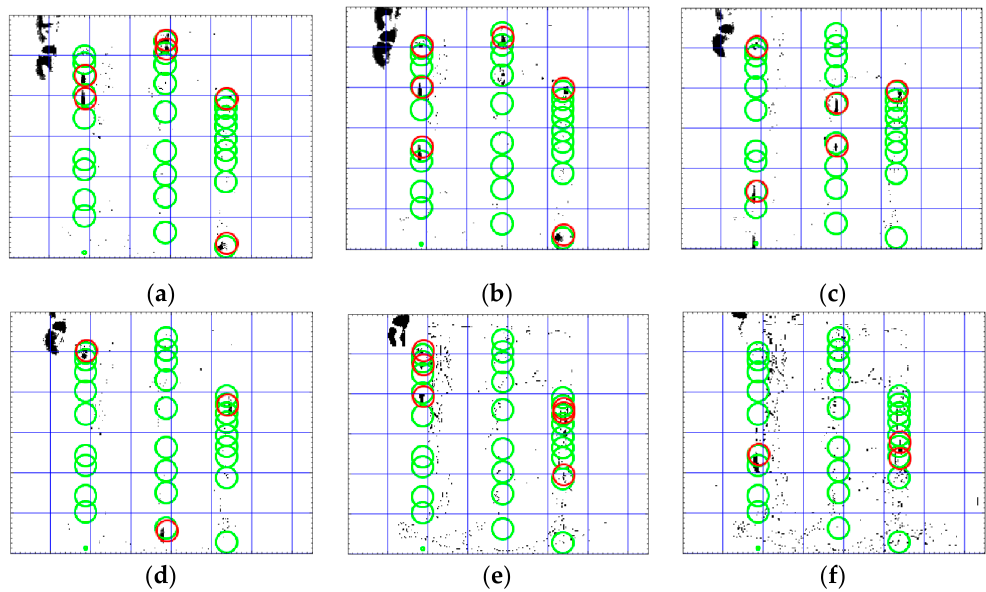
Figure 5. Detected leakage in test videos using the proposed multi Kalman filter method in six subsequent frames ( a – f ) in Video 6. The green circles show the matched points between positions predicted by Kalman filters and the measured possible positions in test data. The red circles show the current position of the leakage in the each frame.